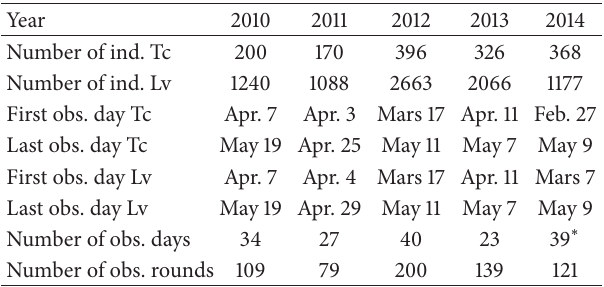
Table 1: Number of observed individuals of T. cristatus (Tc) and L. vulgaris (Lv), the first and last day of observation, the number of observation days, and the number of observation rounds for the period 2010 to